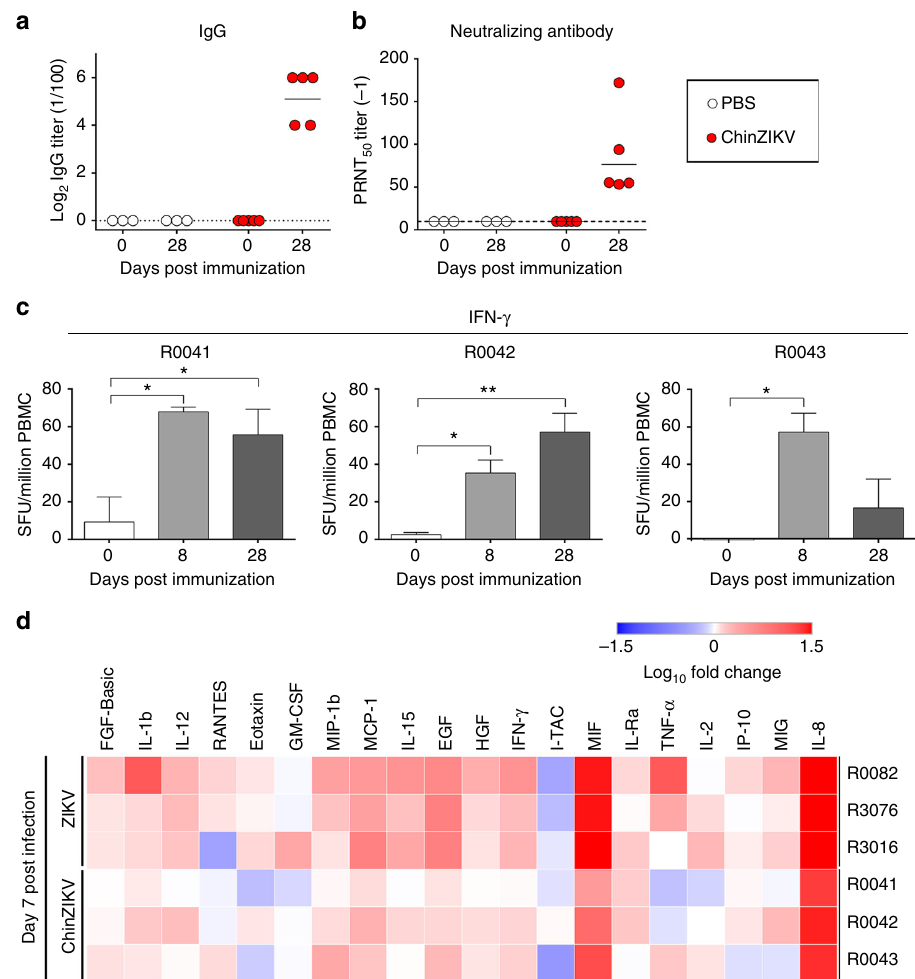
Fig. 3 ChinZIKV elicits ZIKV-speci fi c humoral and cellular immune responses in non-human primates. a , b Monkeys were immunized s.c. with a single dose of ChinZIKV ( n = 5) or PBS as a control ( n = 3). ZIKV-speci fi c IgG and neutralizing antibody titers were determined by ELISA and PRNT 50 , respectively. Dotted lines indicate the limits of detection. c PBMCs from immunized monkeys were collected at the indicated times. The production of IFN- γ by PMBCs stimulated with the ZIKV E protein was measured by ELISPOT assay and expressed as spot-forming units (SFU) per 10 6 PBMCs. Experiments were performed in duplicate (error bars represent SD). Signi fi cance was calculated using a one-way ANOVA with multiple comparison tests (*, P -value < 0.05; **, P -value < 0.01). d Heat map of the cytokine pro fi le in sera from the monkeys inoculated with ChinZIKV or ZIKV at day 7 post inoculation. Each sample was analyzed using a Monkey Cytokine Magnetic 29-Plex Panel kit. Each cytokine level is summarized as the log 10 of the ratio relative to baseline (Day